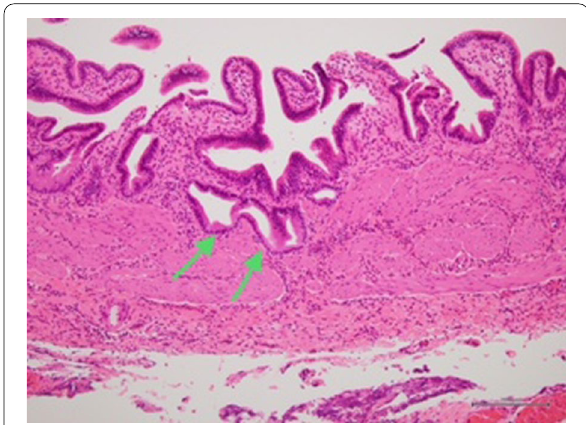
Fig. 4 Histopathological findings of the gallbladder. The Rokitansky– Aschoff sinus (arrows) is identified in the wall of the cystic structure. The pathological diagnosis of the cystic structure is of an ectopic